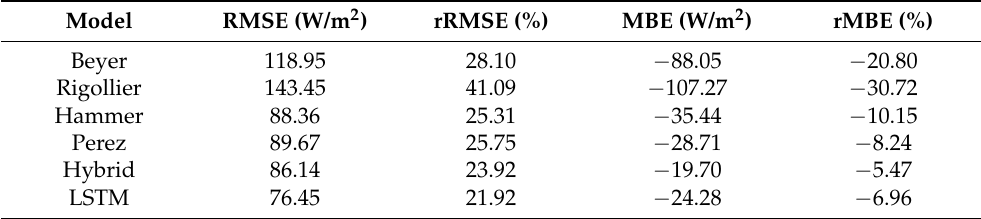
Table 7. Accuracy of the semi-empirical models and LSTM model from October to December